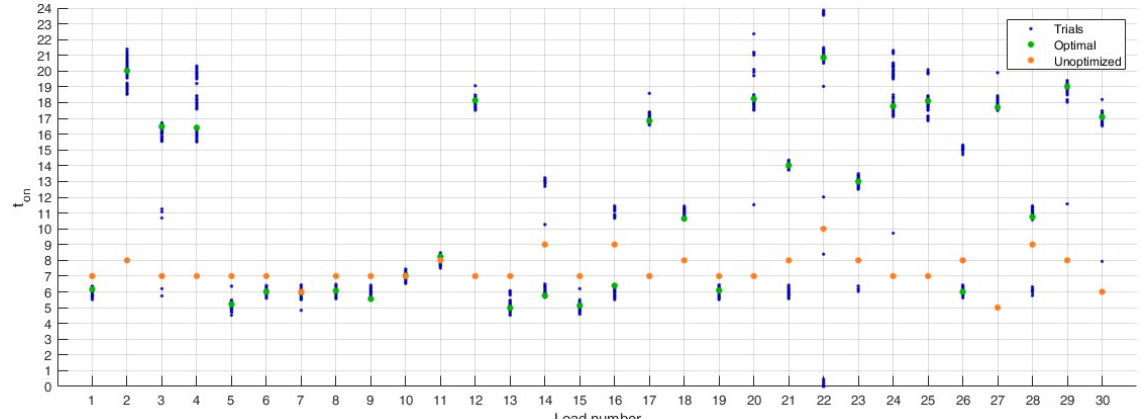
Figure 16. Distribution of the final solutions with the labour cost. The algorithm shifts several load during the